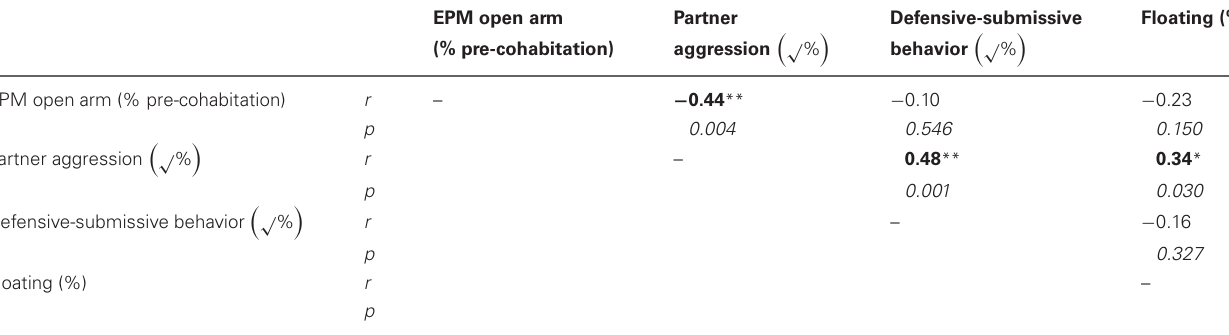
Table 2 | Bivariate correlations for the behavioral measures used in the